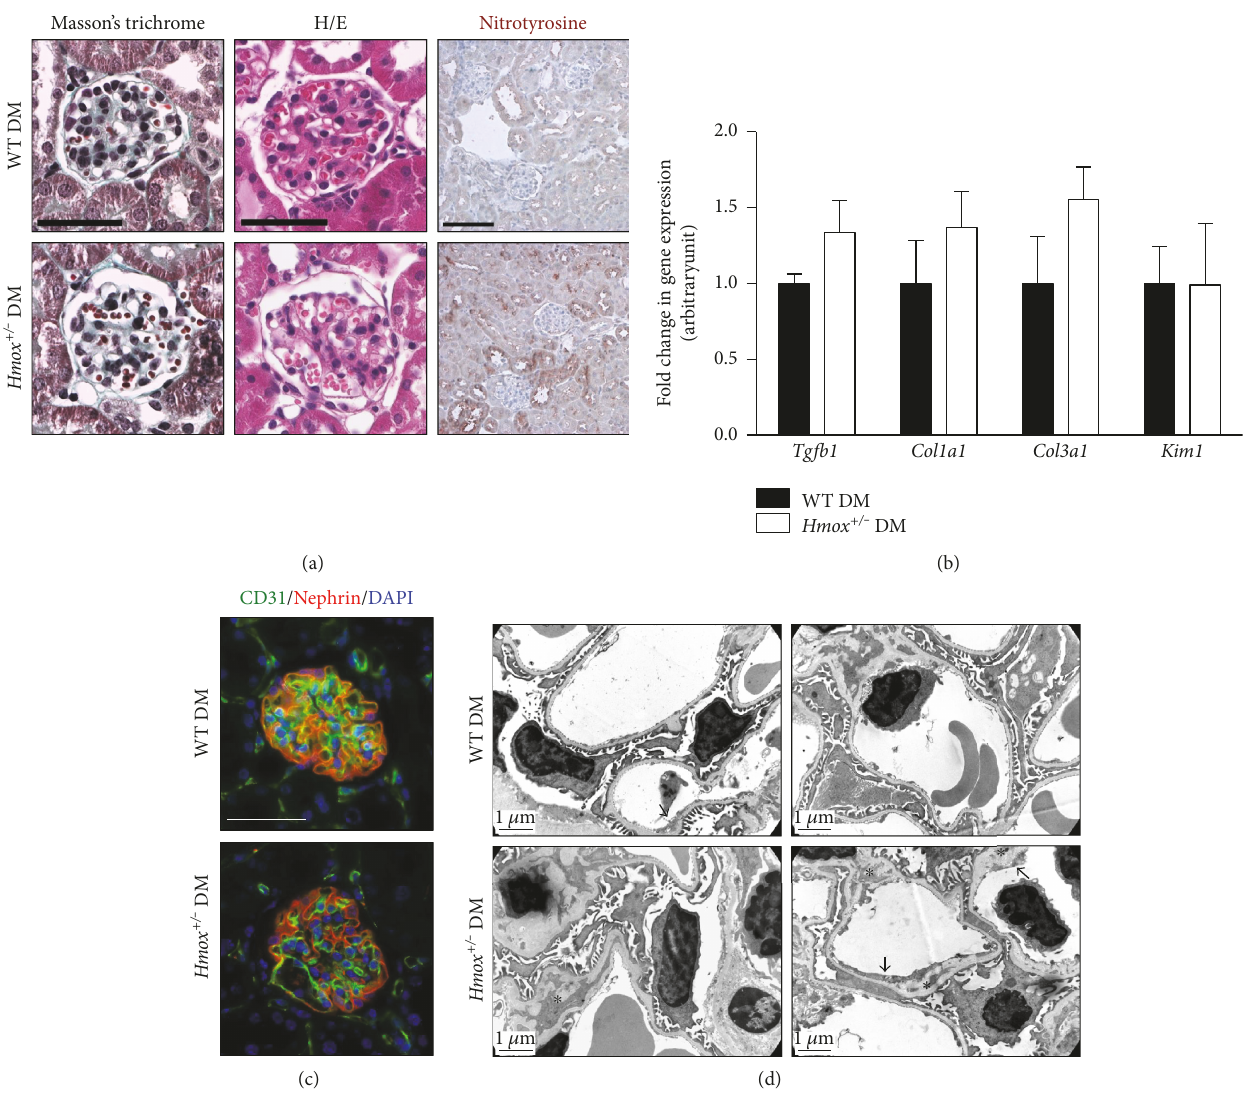
Figure 2: Mice with Hmox haploinsu ffi ciency develop glomerular microvascular lesions under diabetes. (a) Representative images of Masson ’ s trichrome staining (left panel), hematoxylin/eosin staining (middle panel), and nitrotyrosine immunohistochemistry (brown, right panel) in 20-week-old WT diabetic and Hmox +/ − diabetic mice. Scale bar 50 μ m (left and middle panel) and 100 μ m (right panel). (b) qPCR analysis of Tgfb1 , Col1a1 , Col3a1 , and Kim1 mRNA expression in renal cortex extracts from 20-week-old WT diabetic and Hmox +/ − diabetic mice. Data represent means ± sem of 5-6 mice. (c) Endothelial cells (CD31, green) and podocyte (nephrin, red) were stained in 20-week-old WT diabetic and Hmox +/ − diabetic mice. Scale bar 50 μ m. Nuclei were stained with DAPI (blue). (d) Representative photomicrographs of transmission electron microscopy sections of glomerular capillary loops of 20-week-old WT diabetic and Hmox +/ − diabetic mice, showing loss of endothelial fenestrations ( ∗ ) and GBM inclusions (arrows) in Hmox +/ − diabetic mice. Scale bar 1 μ